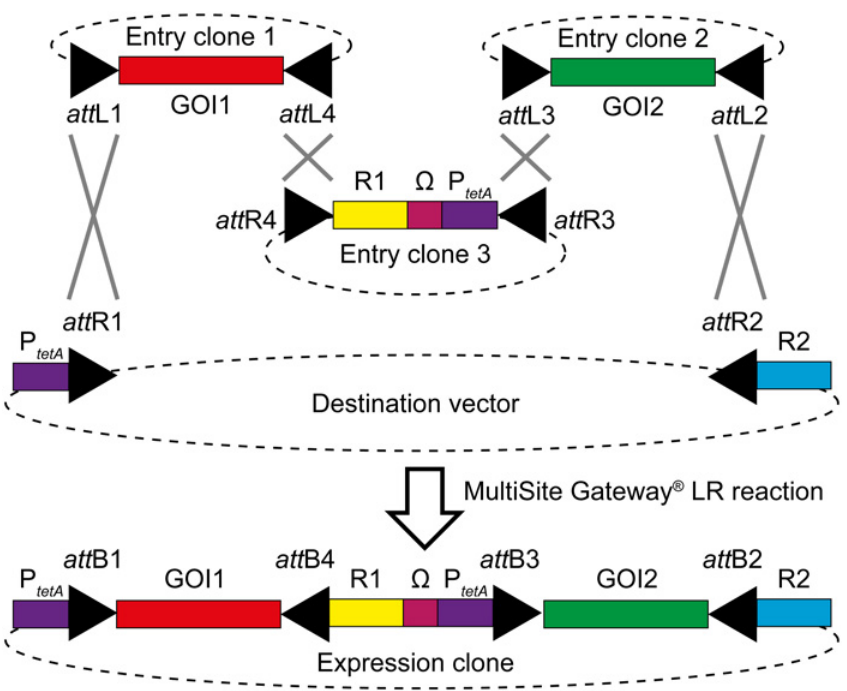
Fig 1. Adaptation of the MultiSite Gateway Pro 3-fragment recombination for use in bacteria. Two Entry clones containing each a gene of interest (GOI) recombine (crossed grey lines) together with a third Entry clone and one Destination vector harboring each a reporter gene (R1/2) to create an Expression clone. The Expression clone contains three DNA elements donated from the three Entry clones and enables expression of the GOI1-R1 and GOI2-R2 fusion genes from tetracycline-inducible promoters (P tetA ). Transcription of fusion genes is stopped by a termination sequence derived from that of the rrnB operon ( Ω